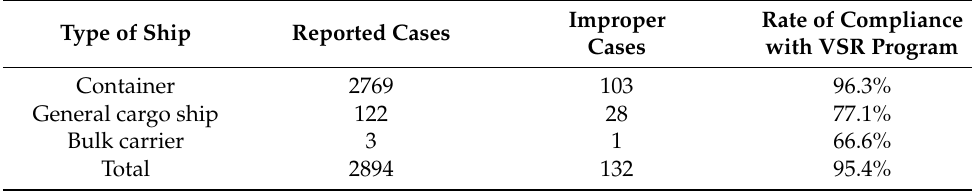
Improper Rate of Compliance Cases with VSR Program